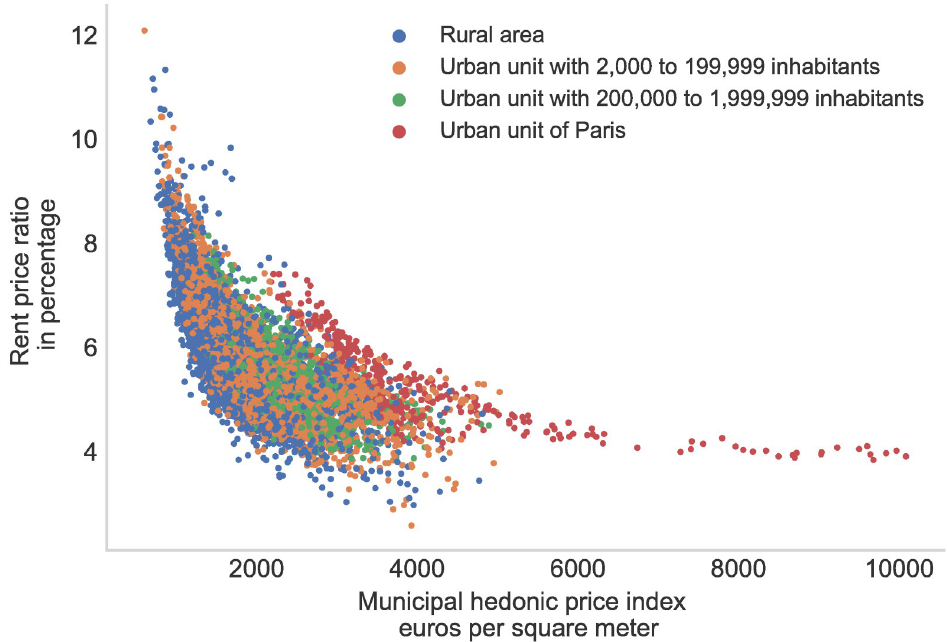
Fig 5. Rent-price ratio in 2017. Note: Price data are taken from the fiscal administrative database Demande de Valeur Foncière , rent data are taken from the database constructed by the authors. The rent-price ratio is calculated as the ratio of the municipal hedonic price index and the hedonic rental index. Only municipalities with more than 10 observations are displayed.